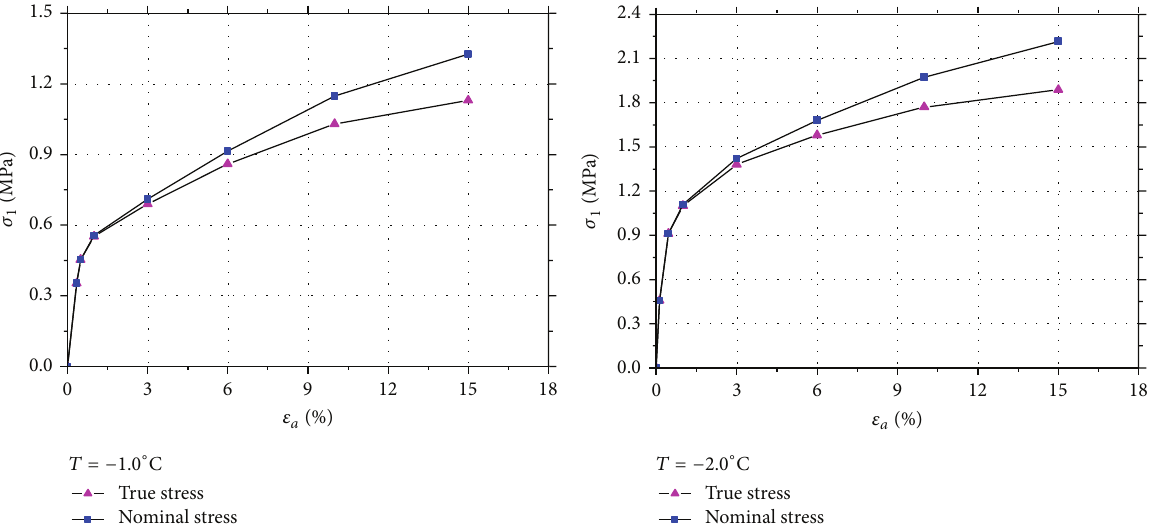
Figure 6: Stress-strain curves of warm and ice-rich frozen